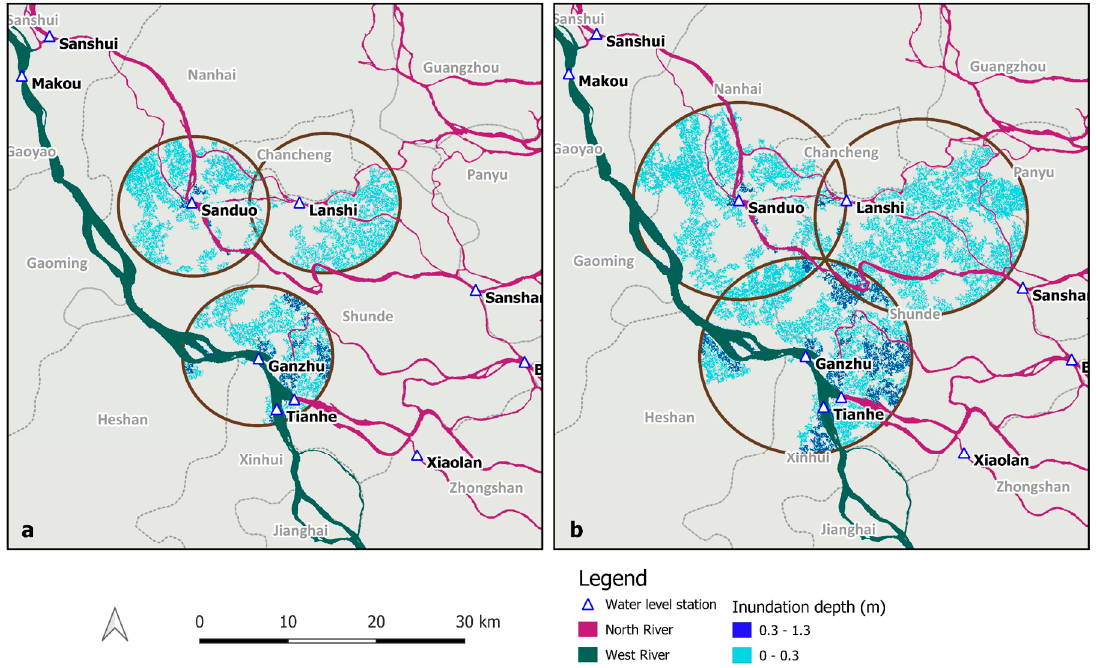
Figure 11. The estimated inundation extent and flood depth under ( a ) Syn A and ( b ) Syn B at Sanduo, Lanshi and Ganzhu areas. Table 4. Summary of the maximum flood depth, total flood area and volume for the two synthetic events.